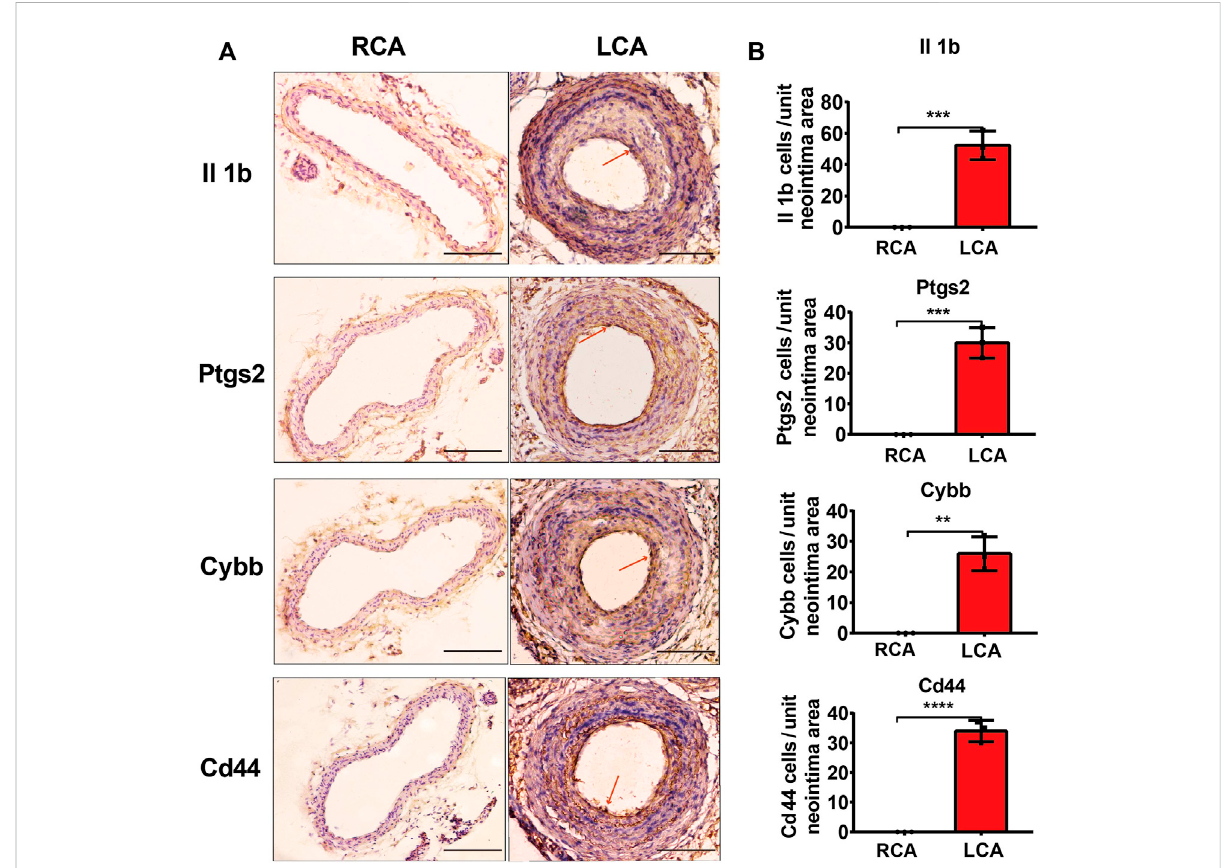
FIGURE 7 Validationofproteinlevels. (A) ImmunohistochemistrystainingofIl1b,Ptgs2,Cybb,andCd44proteins14 days afterligationintheRCAandLCA groupsinmice. (B) QuantitativeanalysisofIl1b,Ptgs2,Cybb,andCd44proteins14 daysafterligationintheRCAandLCAgroupsinmice.Thearteries wereharvestedfromuninjuredRCA(thatunderwentashamoperation)andinjuredLCA14daysafterligation.Theredarrowsrepresentpositivecells. A two-tailed unpaired Student ’ s t-test was used to compare the two groups. Data are expressed as the means ± SD, n = 3. ** p < 0.01; *** p < 0.001; **** p < 0.0001; compared with the RCA group. Original magni fi cation, ×100. Scale bar: 50 μ m.